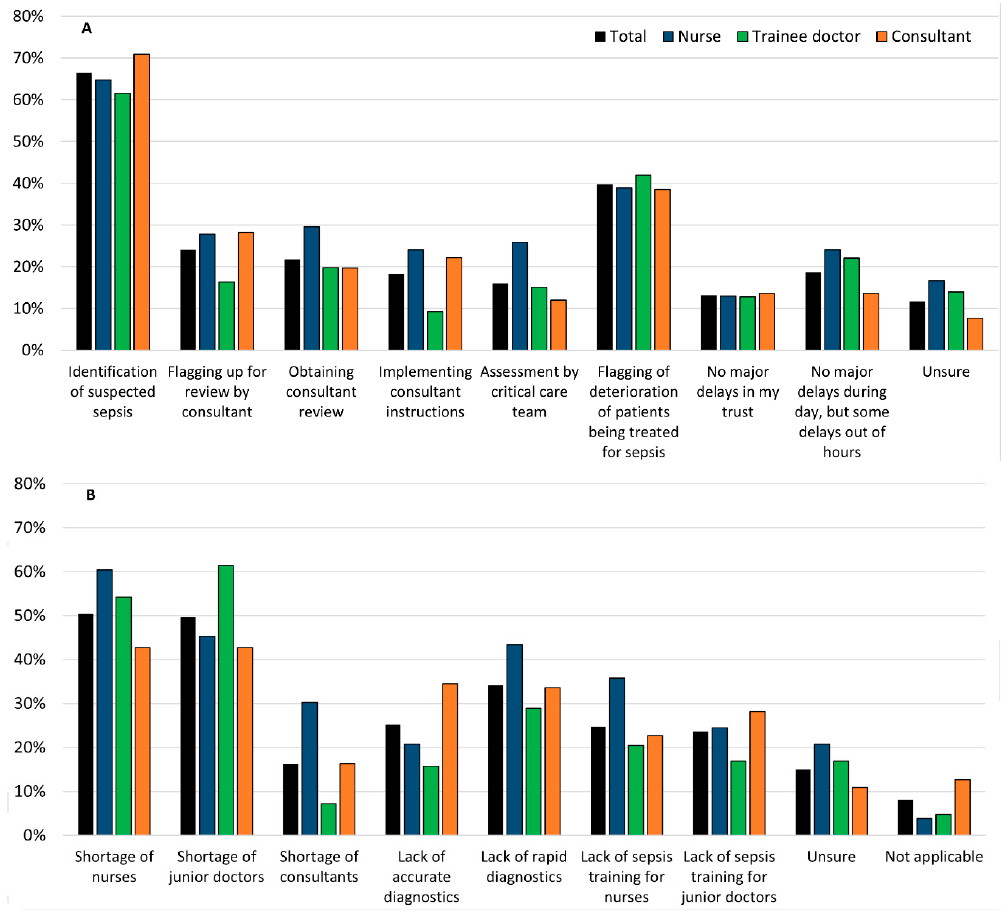
Figure 2. Percentage of respondents identifying ( A ) common delays in management of sepsis patients and ( B ) causes of delays.